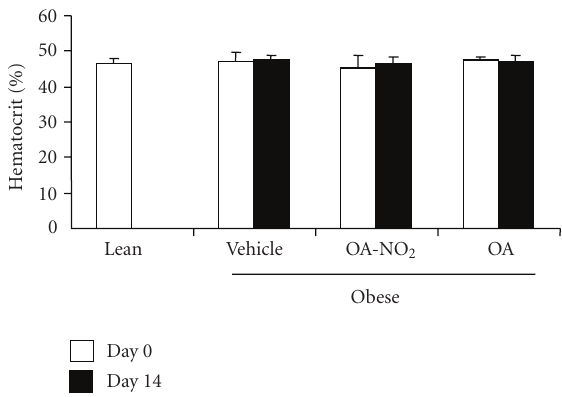
Figure 9: Hematocrit in obese Zucker rats before and after 14- d infusion with vehicle, OA-NO 2 , or OA. Lean rats with vehicle treatment were used as controls. Lean: n = 3; Vehicle: n = 7; OA- NO 2 : n = 5; OA: n = 5. Data are mean ±